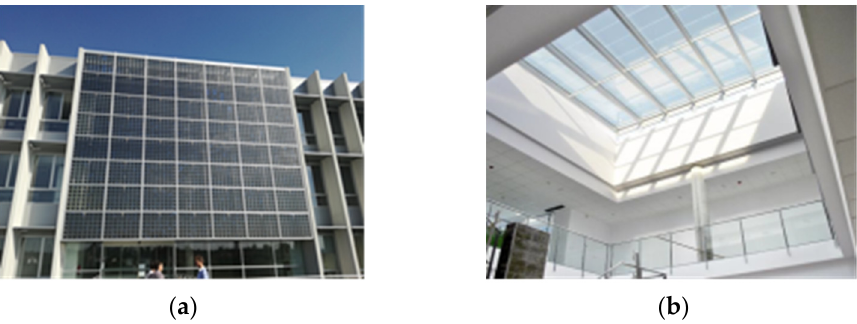
Figure 2. View of the photovoltaic installations ( a ) south system; and ( b ) skylight.